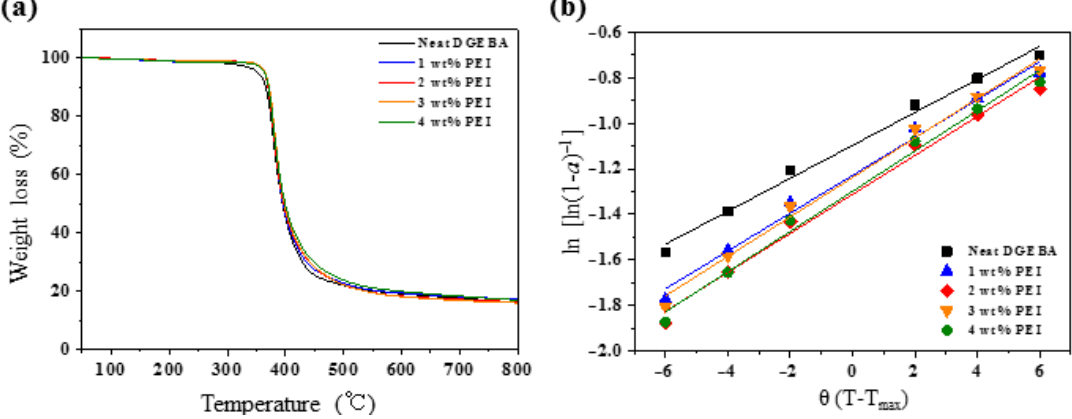
Figure 4. Thermal stability of the DGEBA/PEI blends: ( a ) TGA curves and ( b ) plots of ln [ ln (1 − α ) − 1 ] vs. θ using the Horowitz–Metzger method [25].